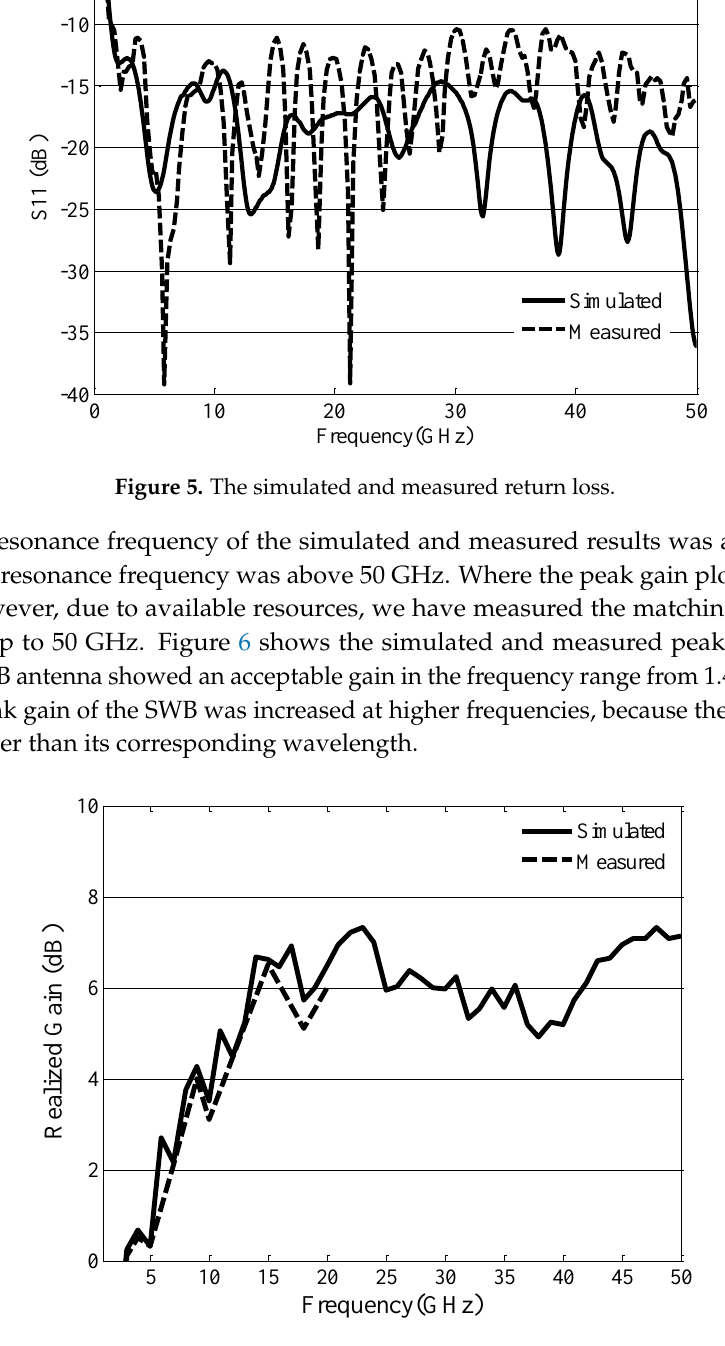
Figure 6. The simulated and measured peak gain.